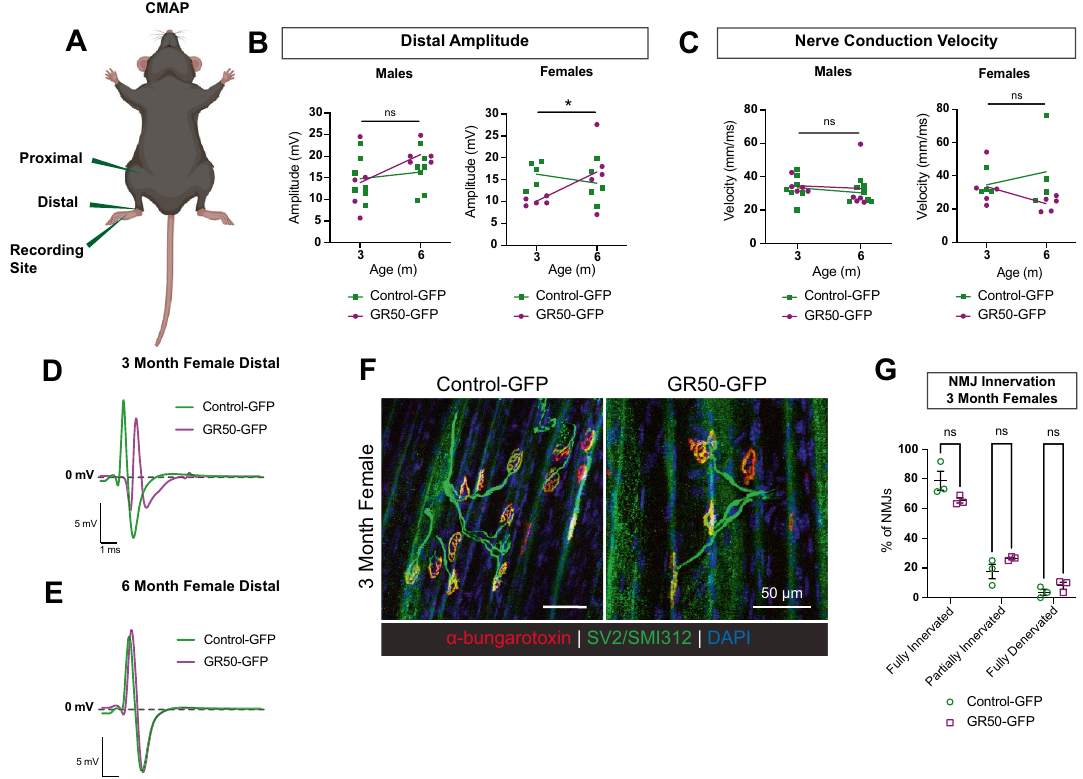
Figure 4. Female mice demonstrate CMAP functional differences absent of abnormal NMJ morphology. ( A ) Schematic of CMAP stimulating and recording electrode placement along the sciatic nerve within the hindlimb of test mice. ( B ) Distal amplitude recordings in male (left) and female (right) control-GFP and GR50-GFP mice at 3- and 6- months old. Males: n = 5 GR50-GFP, 7 control-GFP; time x genotype p = 0.2385. Females: n = 5 mice per genotype; time x genotype p = 0.0386. Two-way ANOVA, Sidak’s multiple comparisons test. ( C ) Nerve conduction velocity in male (left) and female (right) control-GFP and GR50-GFP mice at 3- and 6- months old. Males: n = 5 GR50-GFP, 7 control-GFP; time x genotype p = 0.8522. Females: n = 5 GR50-GFP, 4 control-GFP; time x genotype p = 0.7671. Two-way ANOVA, Sidak’s multiple comparisons test. ( D ) Representative distal CMAP stimulus trace of a female control-GFP and GR50-GFP mouse at 3 months and ( E ) 6 months. Dashed line indicates 0 mV. ( F ) Representative images of the neuromuscular junctions of the extensor digitorum longus muscle of female control-GFP and GR50-GFP mice at 3-months-old stained for presynaptic SV2 and postsynaptic alpha-bungarotoxin. Scale bar = 50 µm. ( G ) Quantification of the innervation status of NMJs of the soleus and extensor digitorum longus muscles of female control-GFP and GR50-GFP mice at 3-months-old. n = 3 mice per time-point, mean ± s.e.m. Two-way ANOVA, Sidak’s multiple comparisons test. Fully Innervated: p = 0.0717, Partially Innervated: p = 0.3016, Fully Denervated: p =